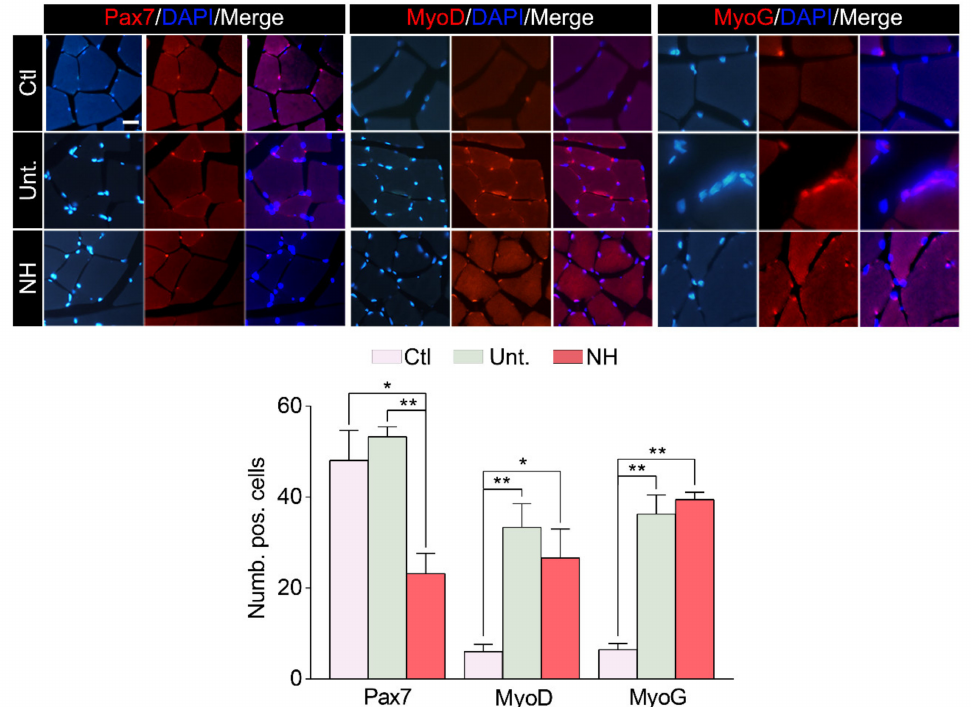
Figure 3. NeuroHeal accelerates satellite cell activation and differentiation after muscle injury. Top, representative mi- crophotographs of the ipsi- and contralateral lesioned gastrocnemius muscle sections revealing the presence of Pax 7, MyoD, and MyoG and stained with DAPI (blue) from the different experimental groups: control (Ctl), injured untreated (Unt.), injured treated with NeuroHeal (NH) at 14 dpi. Scale bar 200 µ m and identical for all corresponding microphotographs as represented in the first image panel, the control condition. Bottom, bar graphs of the average number of positive satellite nuclei for Pax7, MyoD, or Myogenin ( n = 3; one-way ANOVA, * p < 0.05, ** p <